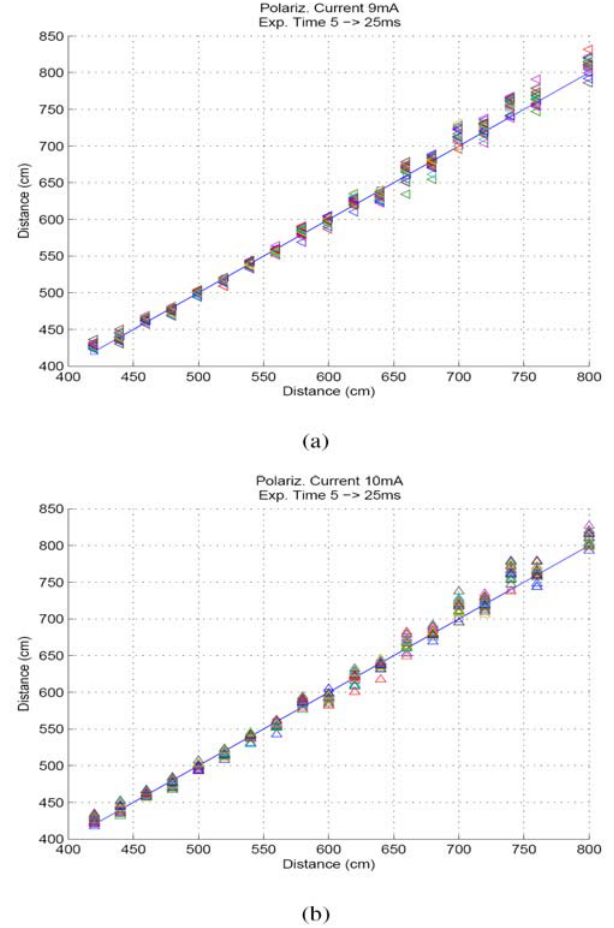
Figure 7. Distance estimation for different exposure times from 5 to 25 ms.